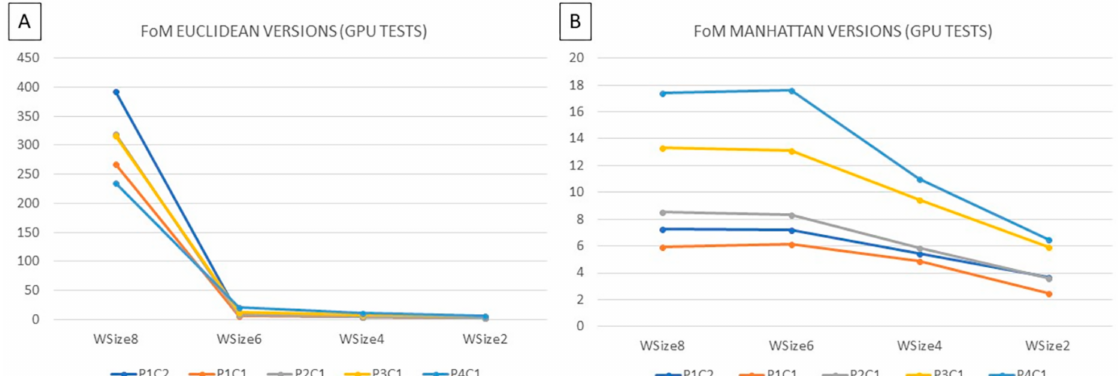
Figure 13. Figure of metric computed comparing ( A ) the Euclidean versions WSize8 , WSize6 , WSize4 and WSize2 with the reference WSize14-Euclidean , ( B ) the Manhattan versions WSize8 , WSize6 , WSize4 and WSize2 with the reference WSize14-Euclidean